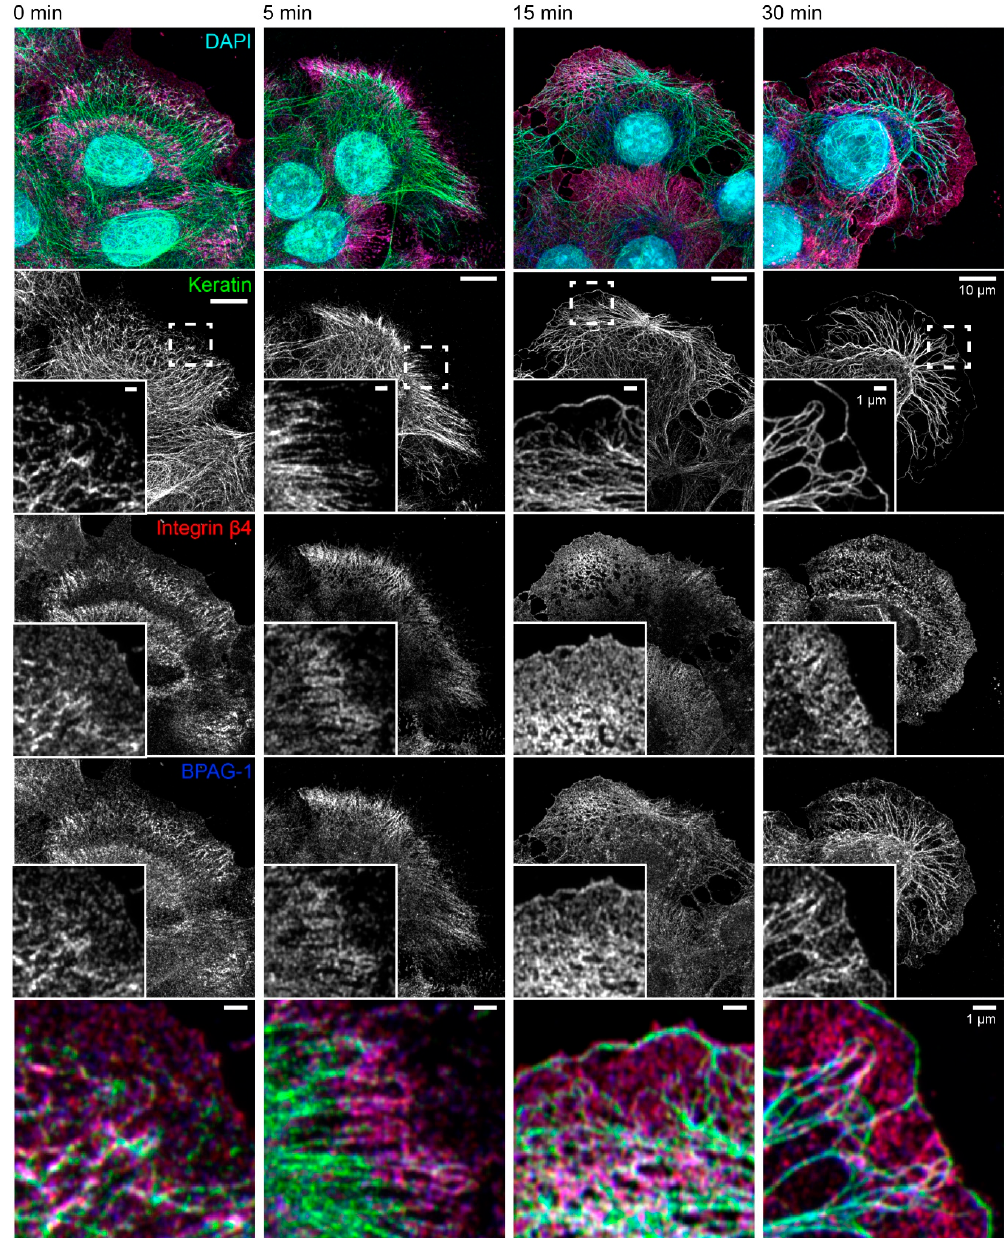
Figure 3. The keratin filament network retracts but remains attached to hemidesmosomes through straightened and bundled radial keratin filaments after actin filament and microtubule disruption. The quadruple fluorescence micrographs show the immunodetection of keratin, integrin β 4 and BPAG-1, together with nuclear DAPI, in methanol-fixed HaCaT keratinocytes before and 5, 15, and 30 min after treatment with 3 µM latrunculin B and 20 µM nocodazole. The insets depict the areas marked by broken lines at higher magnification and as merged images in the bottom panel. Note that keratin filament bundles are attached to integrin β 4-positive and BPAG-1-positive hemidesmosomes before treatment. The bulk of the keratin network retracts within 5 min of drug addition, while remaining attached to hemidesmosomes in the cell periphery. After 15 min, the keratin network is composed of thicker keratin filament bundles and has a larger mesh size. Additionally, new keratin filaments are detected in the juxtamembraneous domain co-localizing with integrin β 4-positive and BPAG-1-positive clusters. A similar and even more pronounced change in keratin network organization is seen at time point 30 min with a few, hemidesmosome-anchored thick keratin bundles and long keratin filaments next to the plasma membrane. All images are maximum intensity projections of entire HaCaT keratinocytes ( n ≥ 7).